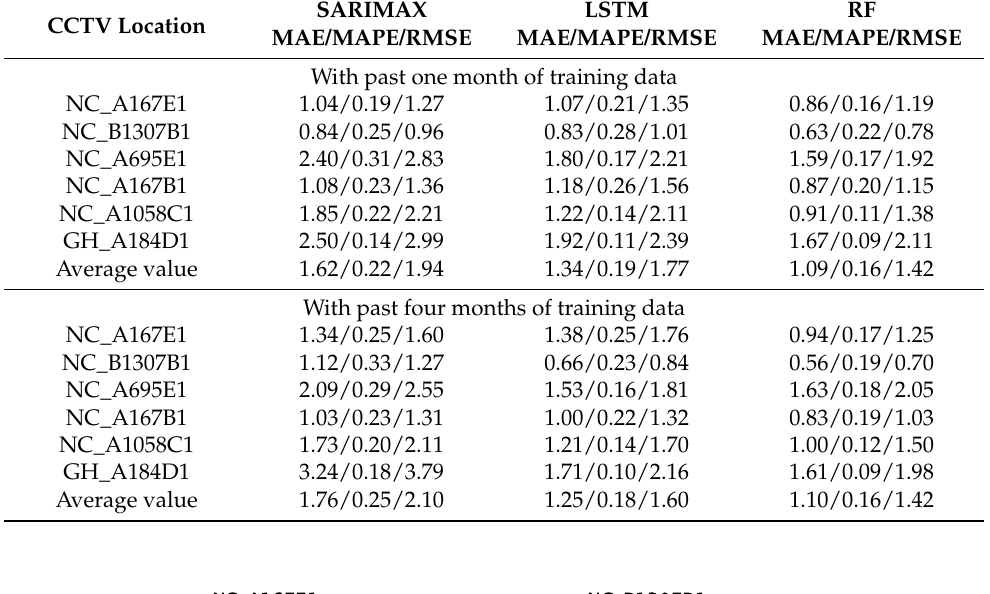
Table 5. Evaluation metrics per CCTV per prediction model 06:00–19:00 2 August 2019.